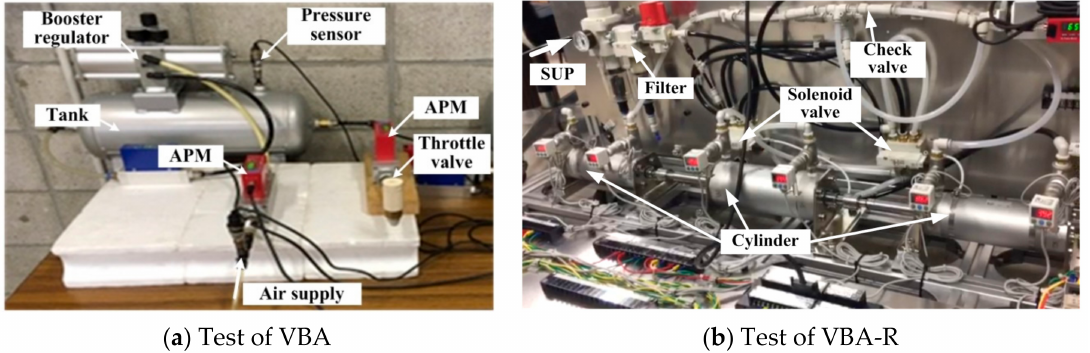
Figure 7. Test rig of energy efficiency test, ( a ) test of VBA and ( b ) test of